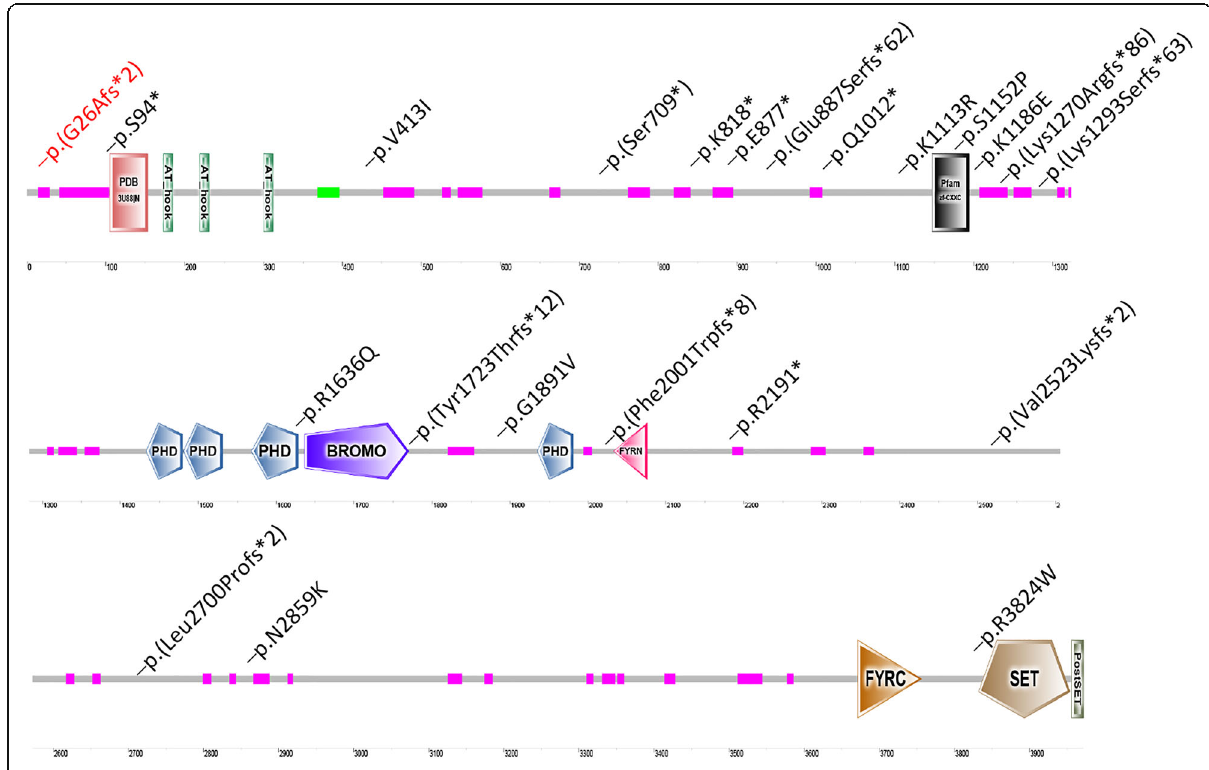
Fig. 3 Locations of ID/DD-associated KMT2A mutations. 22 mutations in affected individuals with ID/DD disorders are mapped. Colored boxes depict specific functional domains of the encoded protein using SMART program (http://smart.embl-heidelberg.de/). The mutation in red represents the current case. Four additional mutations with no predicted protein positions are not shown in the